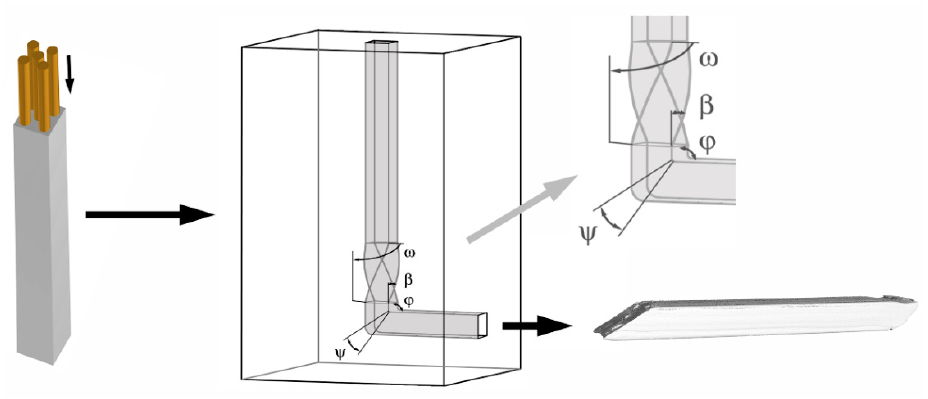
Figure 1. Schematic depiction of manufacturing Al/Cu composite by TCAP.